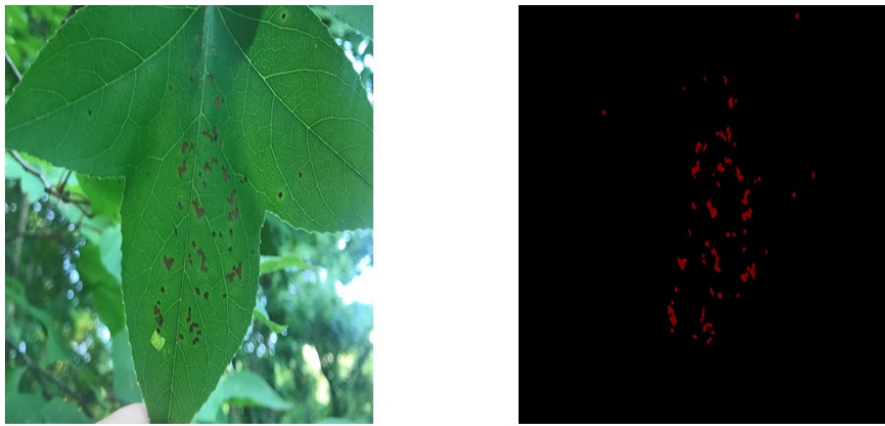
Figure 1. Image marking results.